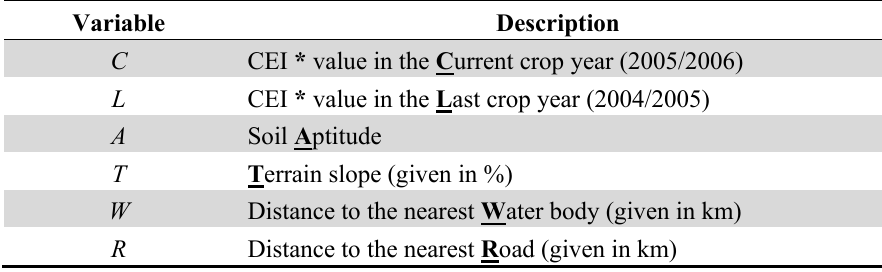
Table 1. Summary of the six context variables used in the soybean mapping case study.